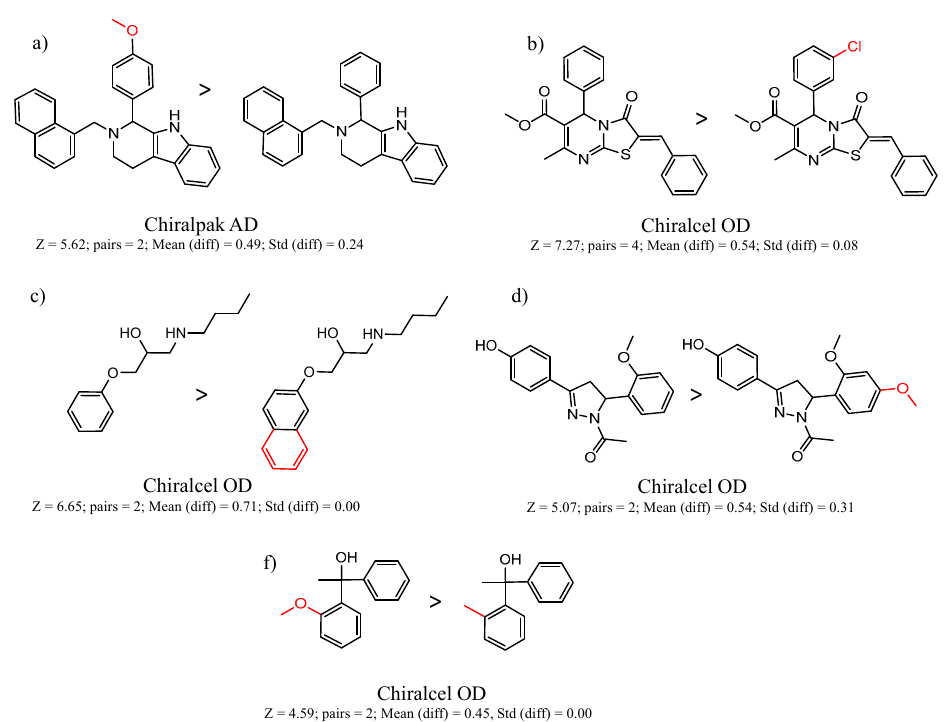
Figure 6. Matched Molecular Pairs illustrating effects of ester vs. alcohol on chiral recognition. ( a ) MMP from Whelk-O CSP ( b ) MMP from Chiralcel CA CSP ( c ) Distribution of MMPs illustrating effects of ester vs. alcohol on chiral recognition on Whelk-O CSPs. MMPs are ranked according to difference in log( α ).